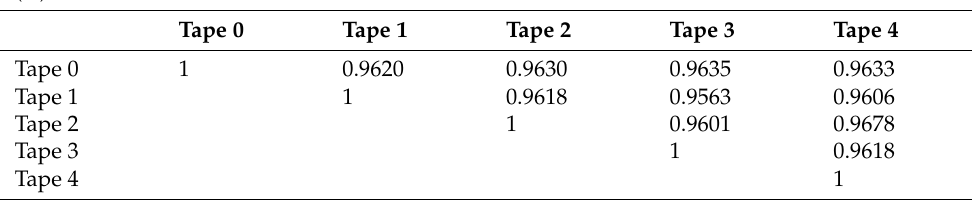
( B ) Correlation between rows of the beta matrix of coefficients for different traders. Tape